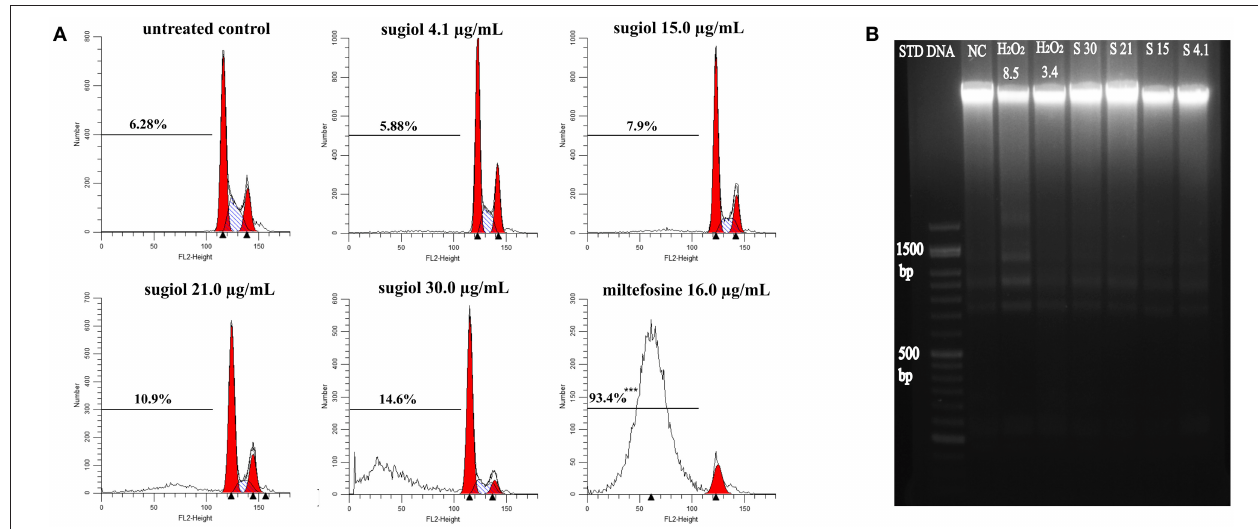
FIGURE 5 | DNA integrity of L. infantum promastigotes treated with free sugiol. (A) DNA fragmentation detected by PI fluorescence on BD FACScalibur flow cytometer Typical representative histograms showed the percentage of sub G0/G1 phase, represented by the cells that lost small DNA fragments. Miltefosine at 16.0 µ g/mL was used as positive control. Three independent experiments were performed and 10,000 events were analyzed in each one. *** p < 0.001, significant difference compared to non-treated promastigotes. (B) Agarose gel electrophoresis of L. infantum promastigotes DNA. (STD DNA) molecular-weight size marker- − 1kb Plus DNA Ladder, (NC) untreated promastigotes, (H 2 O 2 8.5) hydrogen peroxide at 8.5 µ g/mL was used as positive control; (S30), (S21), (S15), and (S4.1): promastigotes DNA after treatment with sugiol at 30.0, 21.0, 15.0, and 4.1 µ g/mL, respectively.